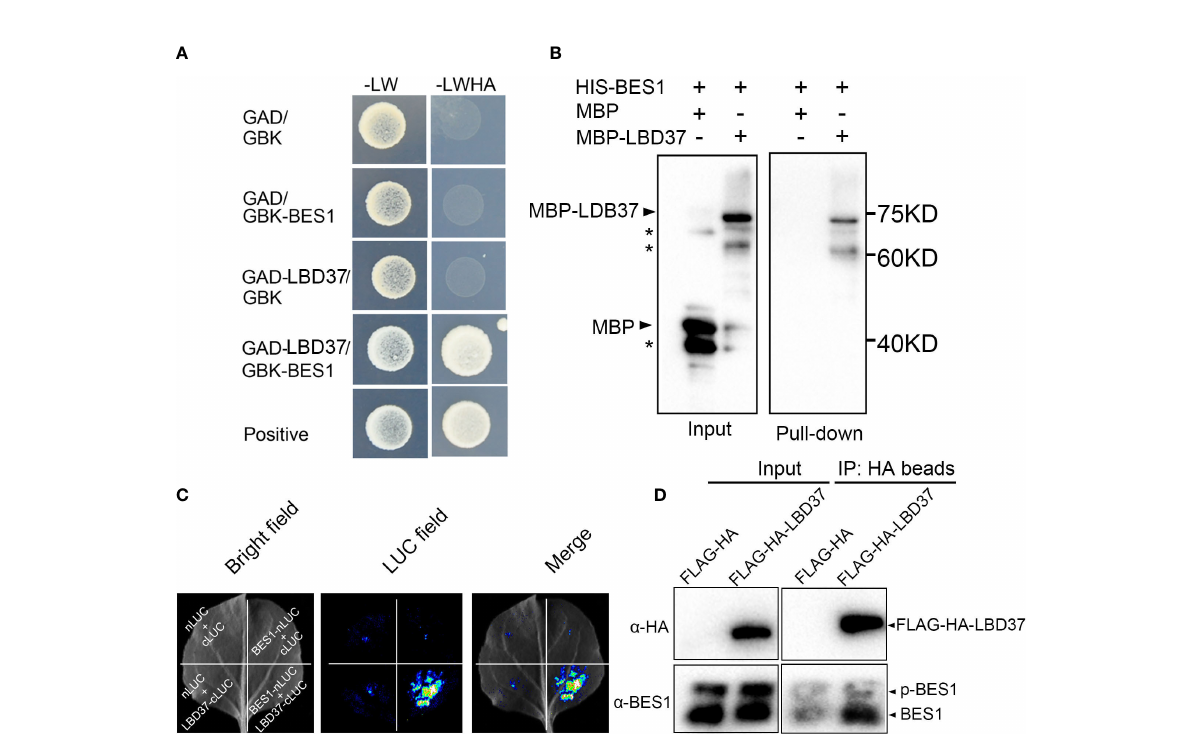
FIGURE 5 BES1 interacts with LBD37. (A) Yeast two hybrid assays. The pGADT7- (shown as GAD) and pGBKT7- (shown as GBK) derivative constructs were shown on the left side. The interaction was selected on the Leu, Trp, His, and Ade dropout medium (-LWHA). (B) HIS pull-down assay. *represents non speci fi c band. BES1 was fused with HIS tag, LBD37 was fused with MBP tag. After coincubation of HIS-BES1 and MBP-LBD37, the proteins were immunoprecipitated with HIS agarose beads. The pull-down protein was detected with anti-MBP antibody. MBP was used a negative control. (C) Split-Luc assays showing BES1 interacting with LBD37 in vivo . BES1 and LBD37 were fused with nLUC and cLUC of luciferase, respectively. Empty vectors were used as negative control. (D) Co-immunoprecipitation (Co-IP) assays. Total proteins from 35S: FLAG-HA or 35S:FALAG-HA-LBD37 plants were immunoprecipitated using anti-HA beads and detected by immunoblotting with anti GFP or anti BES1 antibody, respectively. The input of proteins for immunoprecipitation was shown on left